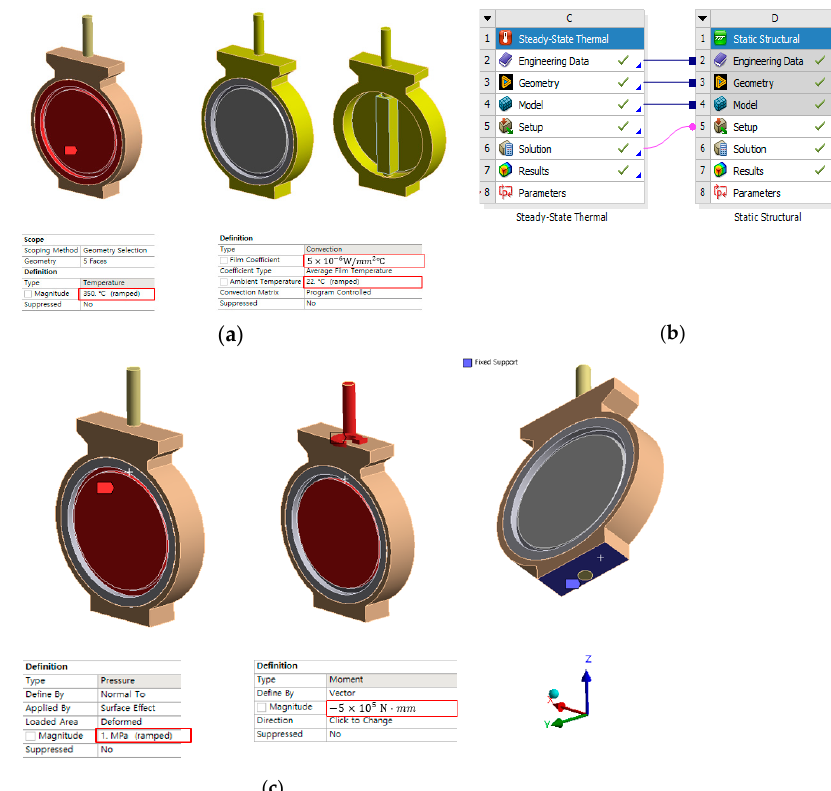
Figure 12. The boundary and load conditions. ( a ) boundary condition of thermal analysis, ( b ) cou-